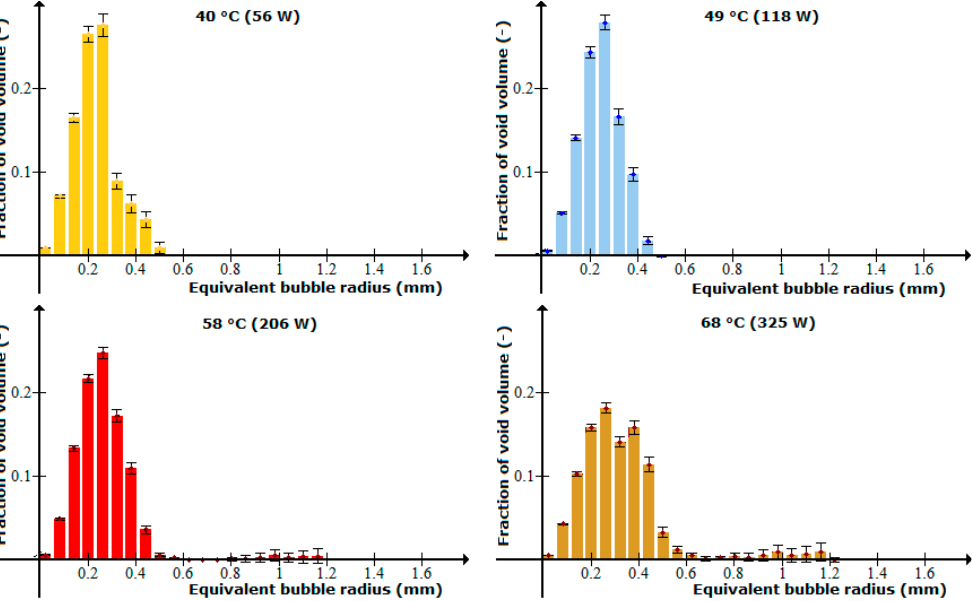
Figure 11. Bubble size distributions for the higher refrigerant mass flux (300 kg/m 2 s). Reprint with permission [20].